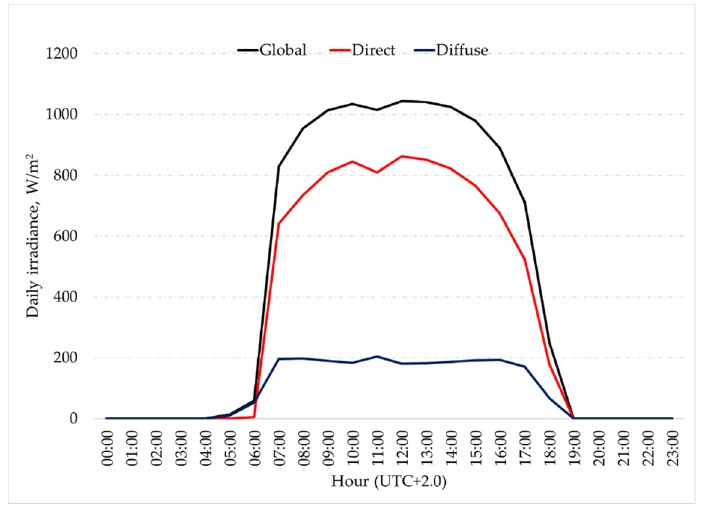
Figure 4. Daily average irradiance for June 2015 in the installation site at the GJU campus.